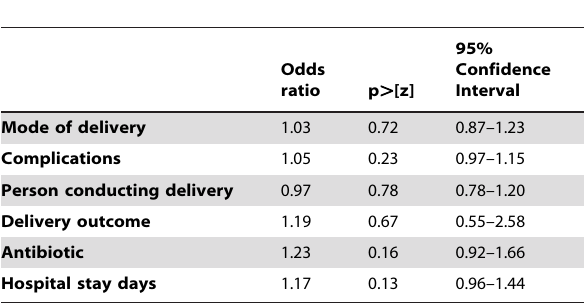
Table 5. Logistic regression looking at the relationship between infection and selected risk factors measured